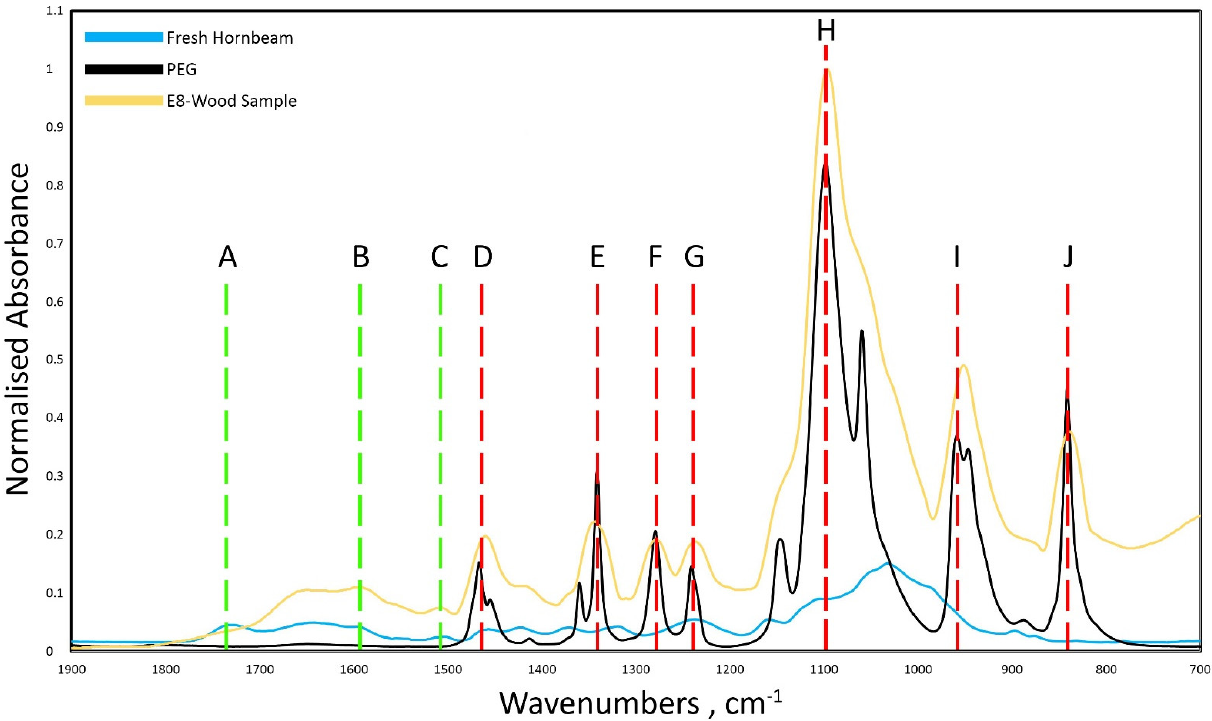
Figure 5. FTIR spectra collected for fresh hornbeam, PEG, and the wood sample collected at the E8 site. In contrast with E8 (hornbeam), the species associated with the E9, E11, and E17 wood samples is oak. A comparison of these samples with fresh oak and PEG samples is shown in Figure 6. Similarly to the E8 wood sample, both the PEG and archaeological wood